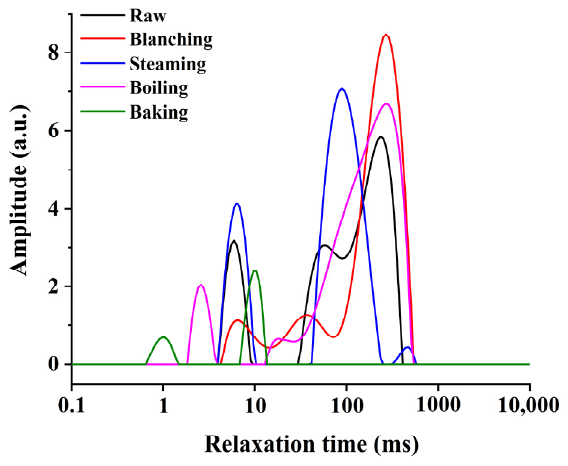
Figure 1. The transverse relaxation time (T 2 ) curves of the raw and cooked U. pinnatifida under different cooking methods.